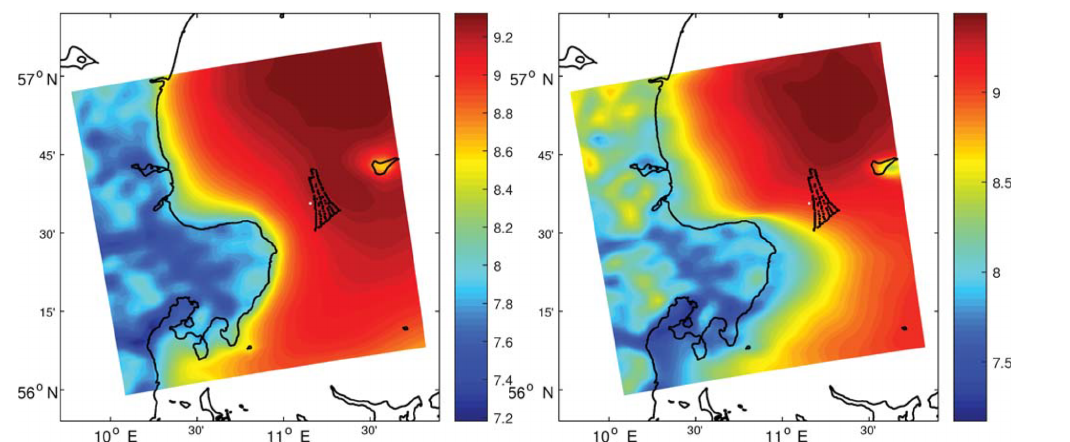
Figure 4. WRF-simulated mean wind speed at hub height in the Kattegat area where the Anholt wind farm is deployed for the year 2014. All data are shown in the left frame and data within the directions 270 ± 30 ◦ at the position of turbine no. 15 are shown in the right frame. Color bars are in meters per second.